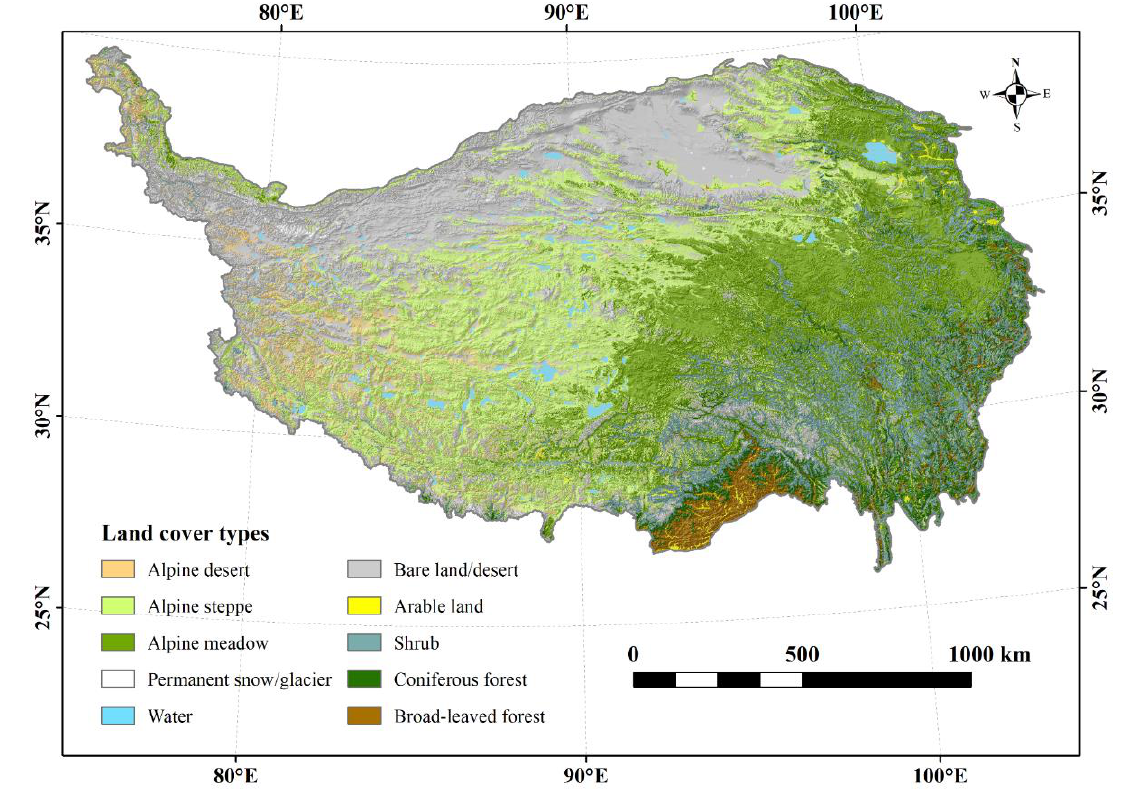
Figure 1. Spatial distributions of the land cover types on the Tibetan Plateau.